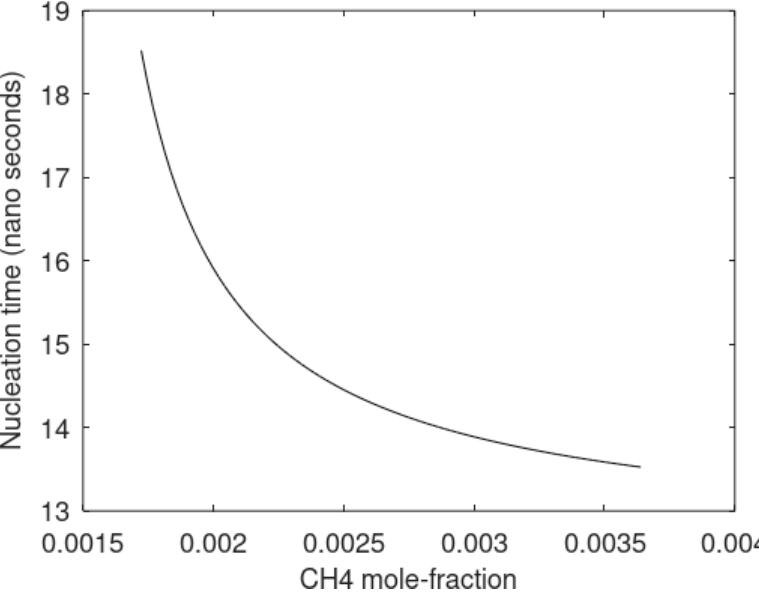
Figure 24. Nucleation times for CH 4 hydrate formation from dissolved CH 4 in water, and liquid water, as function of CH 4 mole-fraction in water. Temperature 280 K and pressure 180 bar.